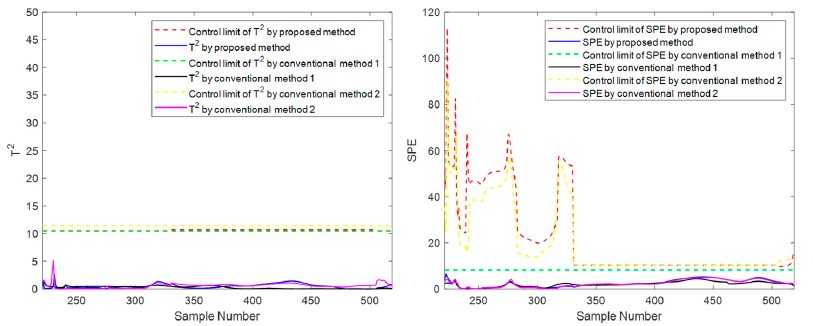
Figure 14. Online monitoring results of batch 71 by the proposed and conventional methods for the second phase.